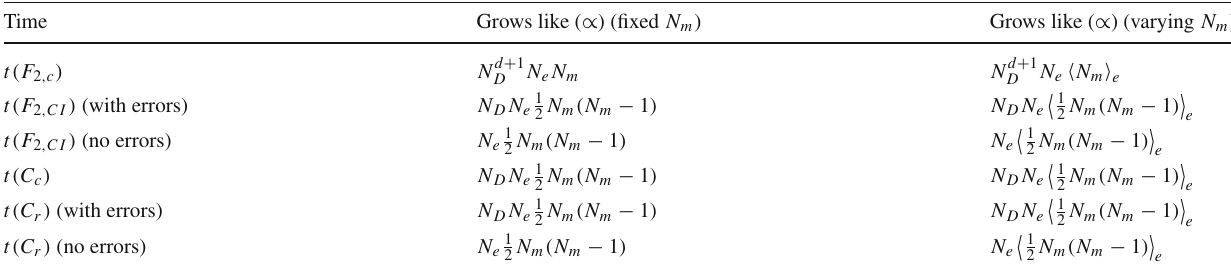
Fig. 5 The running time for F 2 in a and C in b and for different techniques as function of the multiplicity N m , for fixed estimation points N D = 30 and N e = 10,000. Points with greater size symbols correspond to varying N m cases Table 1 The dependence on the involved parameters, N D , N e and N m (for large values), of the computation